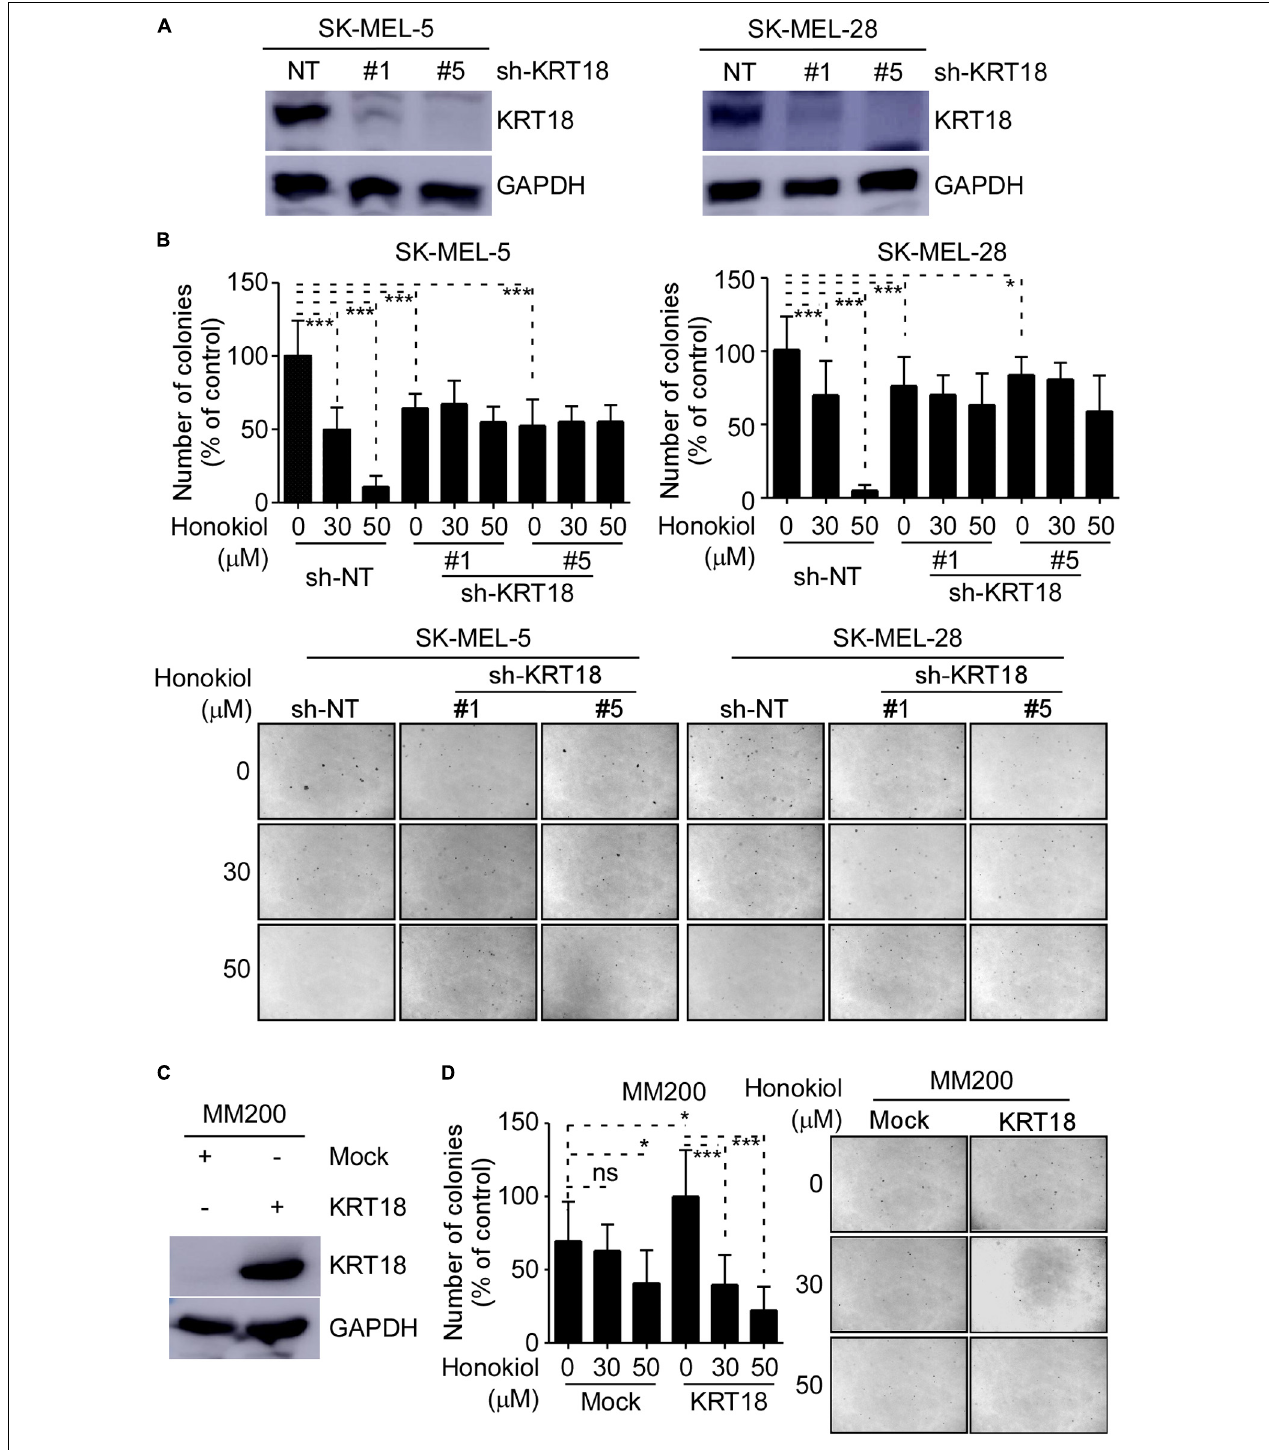
FIGURE 4 | Inhibitory effect of honokiol on melanoma cell growth is dependent upon KRT18 protein level. (A) Western blot analysis showing KRT18 expression in SK-MEL-5 and SK-MEL-28 cells stably transfected with sh-NT or sh-KRT18. (B) Effect of KRT18 knockdown on anchorage-independent growth of honokiol treated SK-MEL-5 and SK-MEL-28 melanoma cells was evaluated by soft agar assay. Clone count (above); Representative images (below). (C) KRT18 protein level after KRT18 overexpression in MM200 melanoma cell. (D) Effect of KRT18 overexpression on anchorage-independent growth of honokiol treated MM200 melanoma cells was evaluated by soft agar assay. Clone count (left); Representative images (right). The asterisks (* p < 0.05, *** p < 0.001) indicate a significant difference in treated cells compared to the control cells.